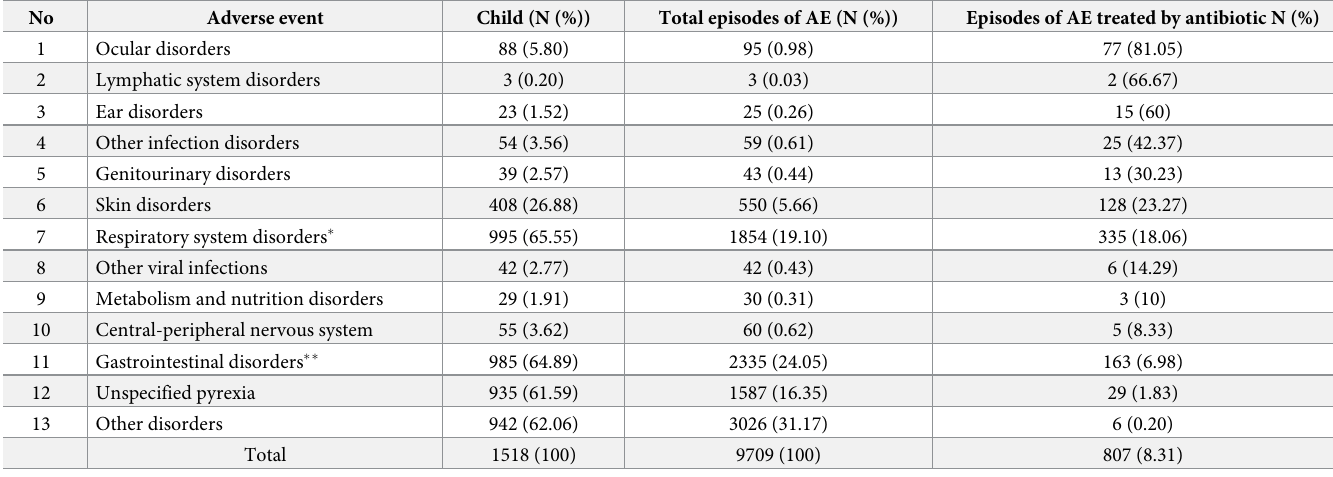
Table 4. Adverse event episodes recorded during the study period.